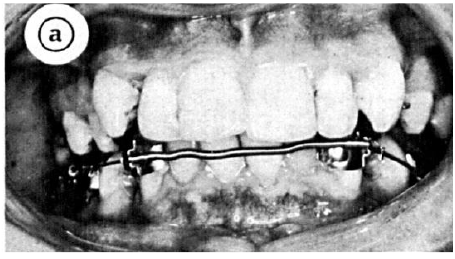
Figure (5): Canine distal movement with coil spring between the canine brackets (b) Coil spring compressed between a soldered stop on the archwire and the canine bracket A soldered post or small piece of wire is soldered on either side of the archwire to stop at the distal margin of the lateral incisor or between the lateral and central incisors (Figure 6). A piece of a little more than half the distance from the stop to the canine is threaded on the archwire, which should closely fit the bracket's slot. Again the canine must be ligated loosely with steel ligature wire (6)